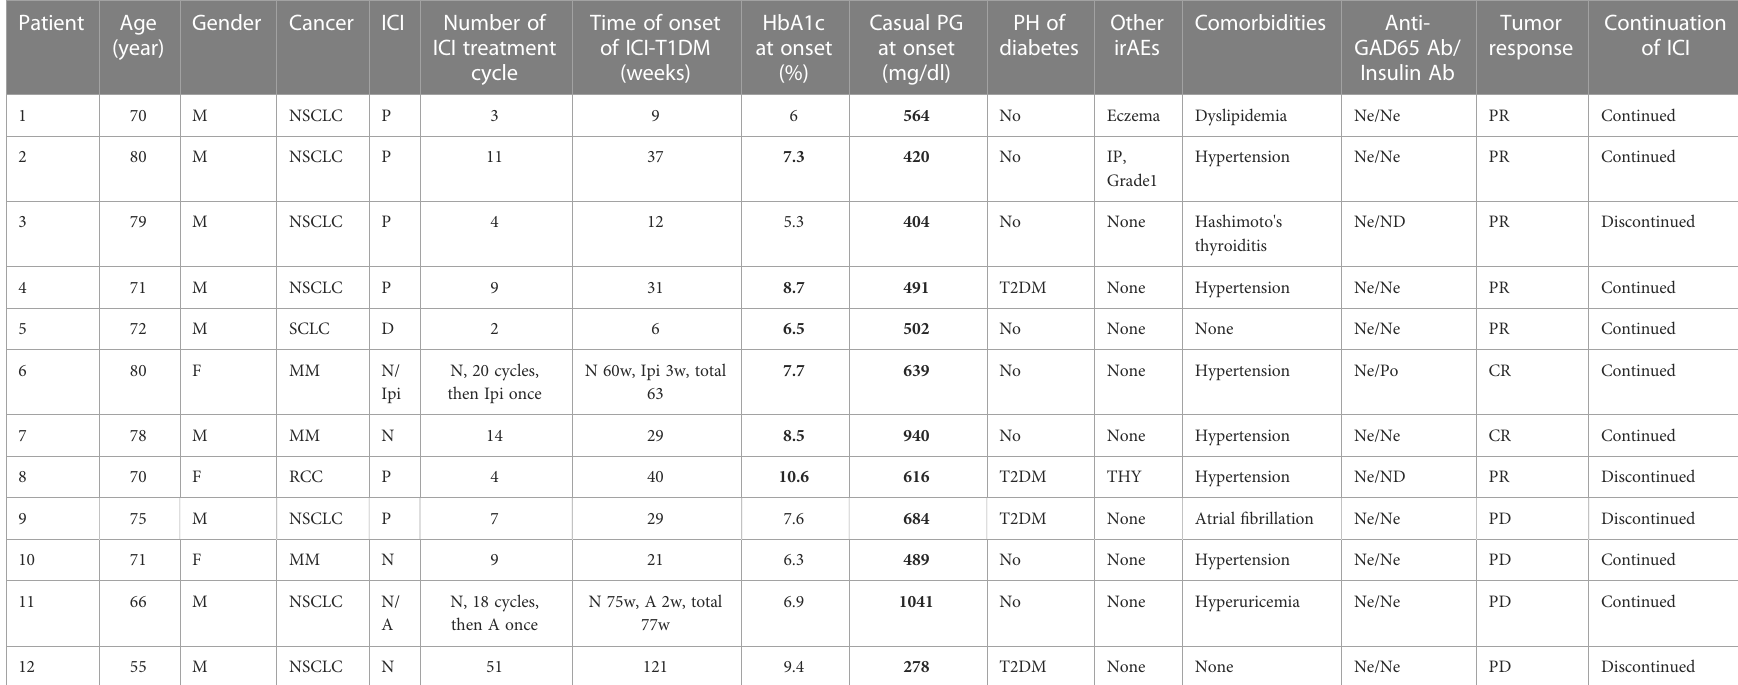
TABLE 1A Clinical characteristics of the patients with